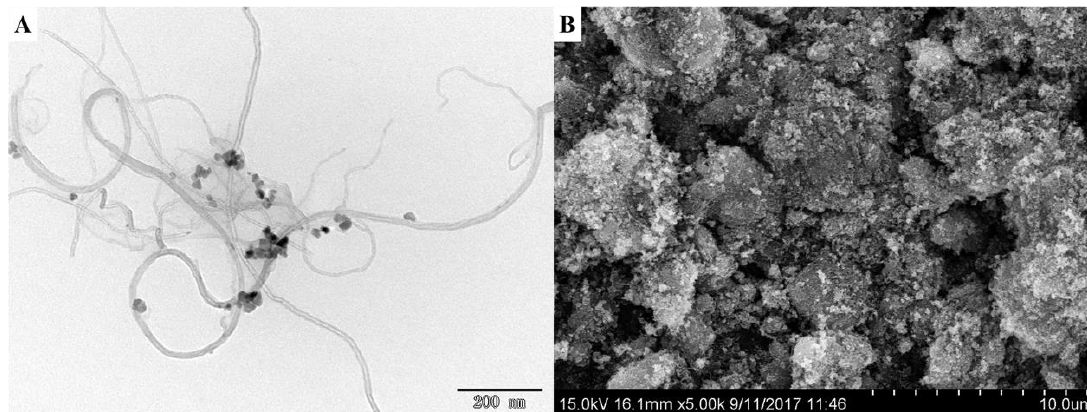
Figure 2. ( A ) transmission electron microscopy image of magnetic multiwalled carbon nanotubes and ( B ) scanning electron microscopy image of zeolitic imidazolate framework based on magnetic multiwalled carbon nanotubes.